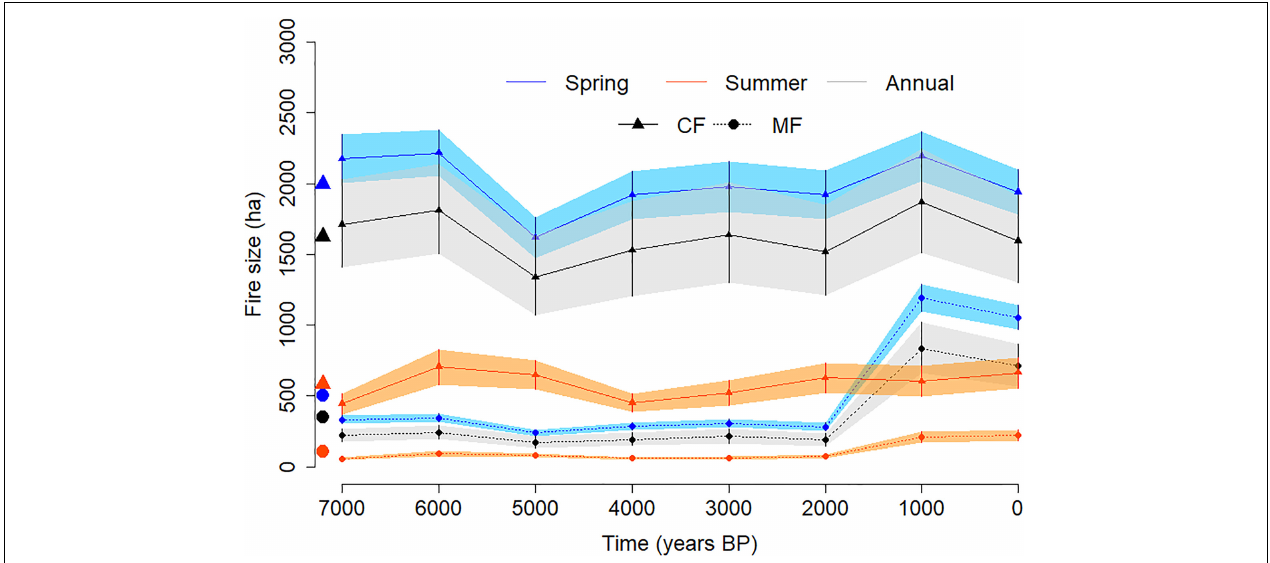
FIGURE 4 | Seasonal and annual fire sizes simulated over the last 7000 years for the coniferous and mixedwood boreal forests (CF and MF, respectively) of eastern Canada using the PFAS fire model. Colors refer to fire seasons: spring (April–June) in blue, summer (July–September) in orange, and annual (April–September) in gray. Symbols associated with error bars [2.5% and 97.5% Bootstrap Confidence Intervals (BCI)] refer to snapshot simulation times (centered on each millennium changeover), while the largest symbols near the y -axis represent mean simulated seasonal or annual Holocene fire sizes, respectively, computed over all millennia.